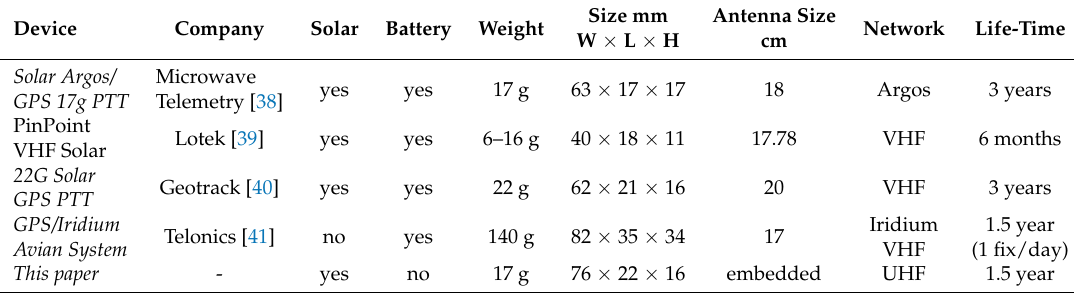
Table 2. GPS Tracker